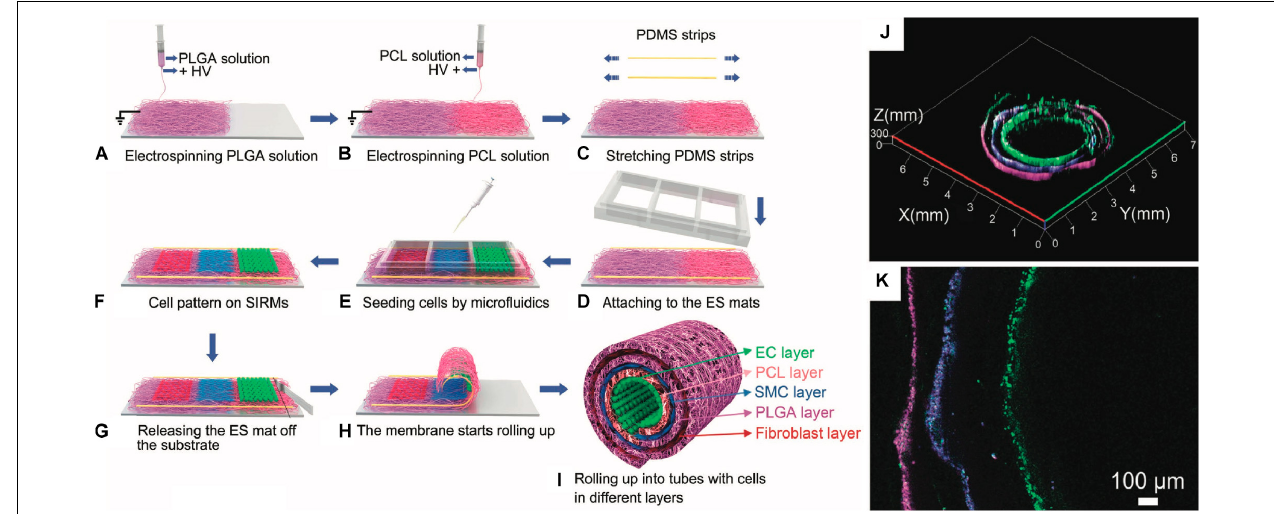
FIGURE 5 | Example of rolling process for a vascular tissue engineered tubular construct (Cheng et al., 2017). (A–I) Schematic detailing process for producing cell-seeded, stress-induced rolling membrane (SIRM). (A–C) Poly(dimethyl siloxane) (PDMS) substrate is coated with poly(DL-lactide-co-glycolide) (PLGA) and poly( ε -caprolactone) (PCL) through electrospinning (ES) under high voltage (HV). (D–F) Resultant substrate is seeded with endothelial cells (ECs), smooth muscle cells (SMCs), and fibroblasts. (G–I) Scaffold is released from pre-stressed substrate, causing rolling. (J,K) Resultant stratified cell layers in rolled substrate: ECs are shown in green, SMCs are shown in blue, and fibroblasts are shown in magenta. Images were reordered from multiple panels, and lettering has been relabeled for consistency as part of this review article (Cheng et al.,